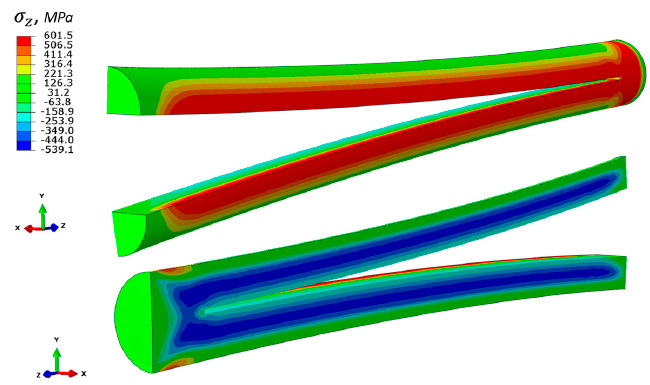
Figure 12. Axial residual stress distribution within the cylindrical rod after cut (MPa).